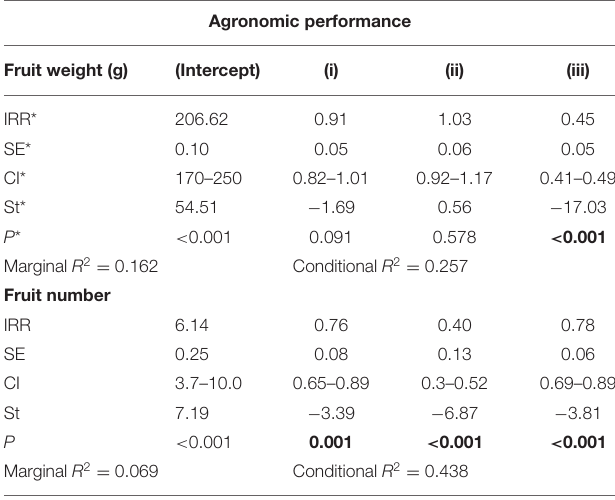
TABLE 2 | Factors influencing agronomic performance via fruit weight and fruit number of tomato plants as dependent